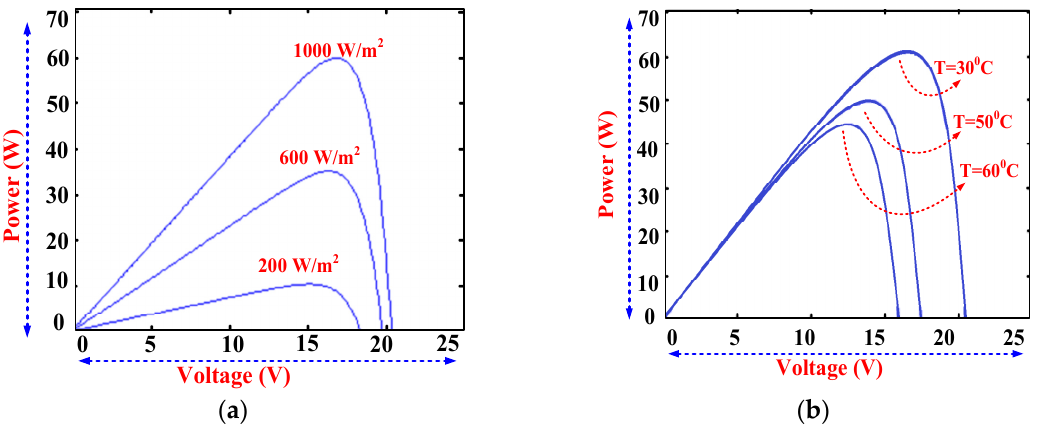
Figure 2. PV characteristics of MSX 60W PV panel for ( a ) varying irradiance ( b ) varying temperature.